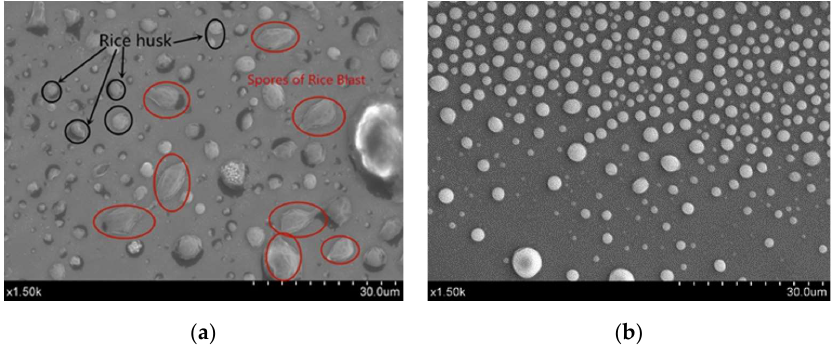
Figure 7. ( a ) Samples collected in collection tank 1; ( b ) samples collected in collection tank 2.